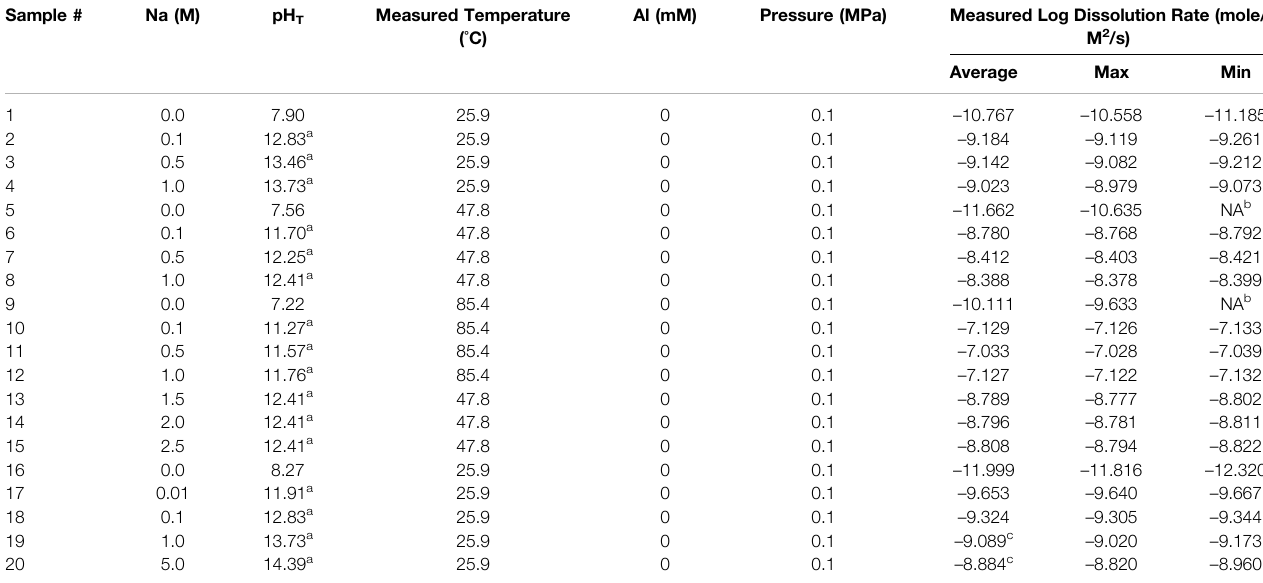
TABLE 2 | Summary of the calculated log dissolution rates (in mole/m 2 /s), along with the fi ve dissolution conditions (i.e., the input features that are used for constructing ML models as detailed in Section 2.3 ) for all batch experiments conducted here. For each experiment, an average dissolution rate, along with the maximum and minimum rates, are given in the table based on three ICP-OES measurements. The temperature values are measured using a pH meter, which are slightly different from the target temperatures (i.e., 25, 50, and 90 °